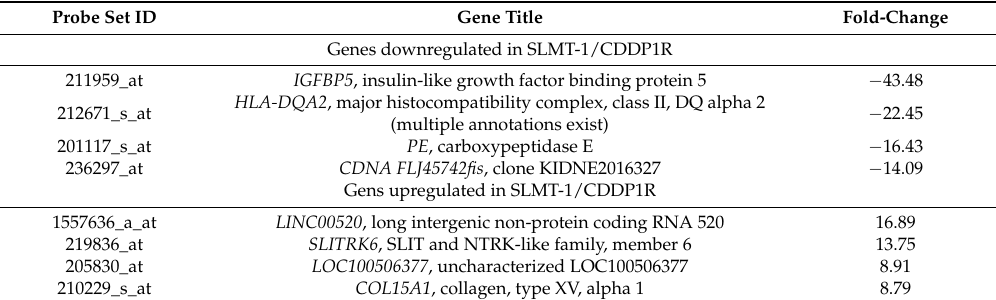
Table 1. Differential genes expression in SLMT-1/CDDP1R and SLMT-1.